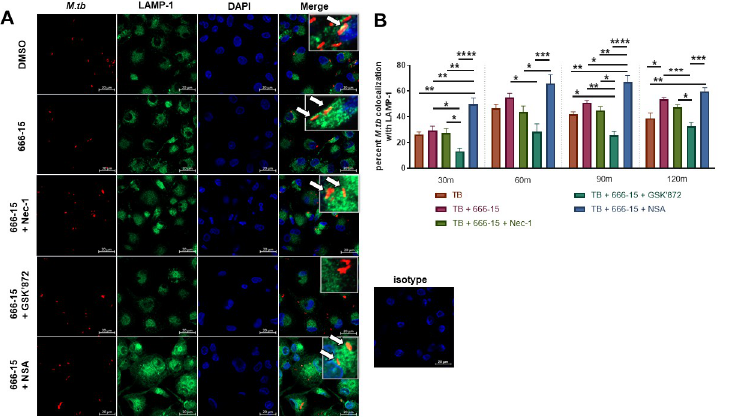
Fig 9. Increased phagolysosomal fusion during CREB inhibition requires RIPK3 activity. A) MDMs were plated on glass coverslips and pretreated for 60 min with DMSO or CREB inhibitor 666–15 +/- Nec-1, GSK’872, or NSA, then infected with mCherry M . tb H 37 R v (red) MOI 10. MDMs were fixed, permeabilized, and stained for LAMP-1 (green) and DAPI (blue). A representative experiment is shown of n = 4–5 donors. B) At the indicated time points, the percent of M . tb colocalizing with LAMP-1 was calculated following manual counting. White arrows indicate colocalization. Data are cumulative ± SEM of n = 4–5 donors. One-way ANOVA with Tukey’s post-test; * p < 0.05, ** p < 0.01, *** p < 0.001, **** p <